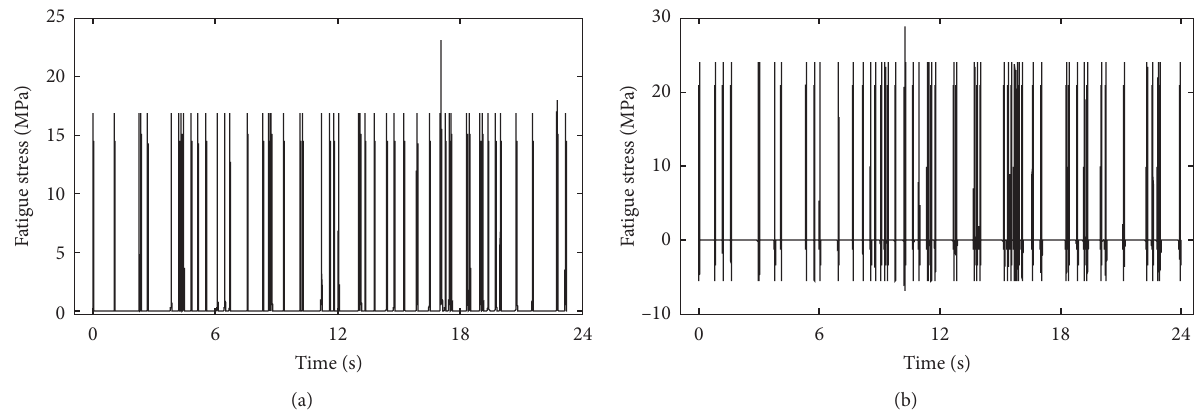
Figure 9: Fatigue stress: (a) the rib-to-deck welded joint and (b) the rib-to-rib welded